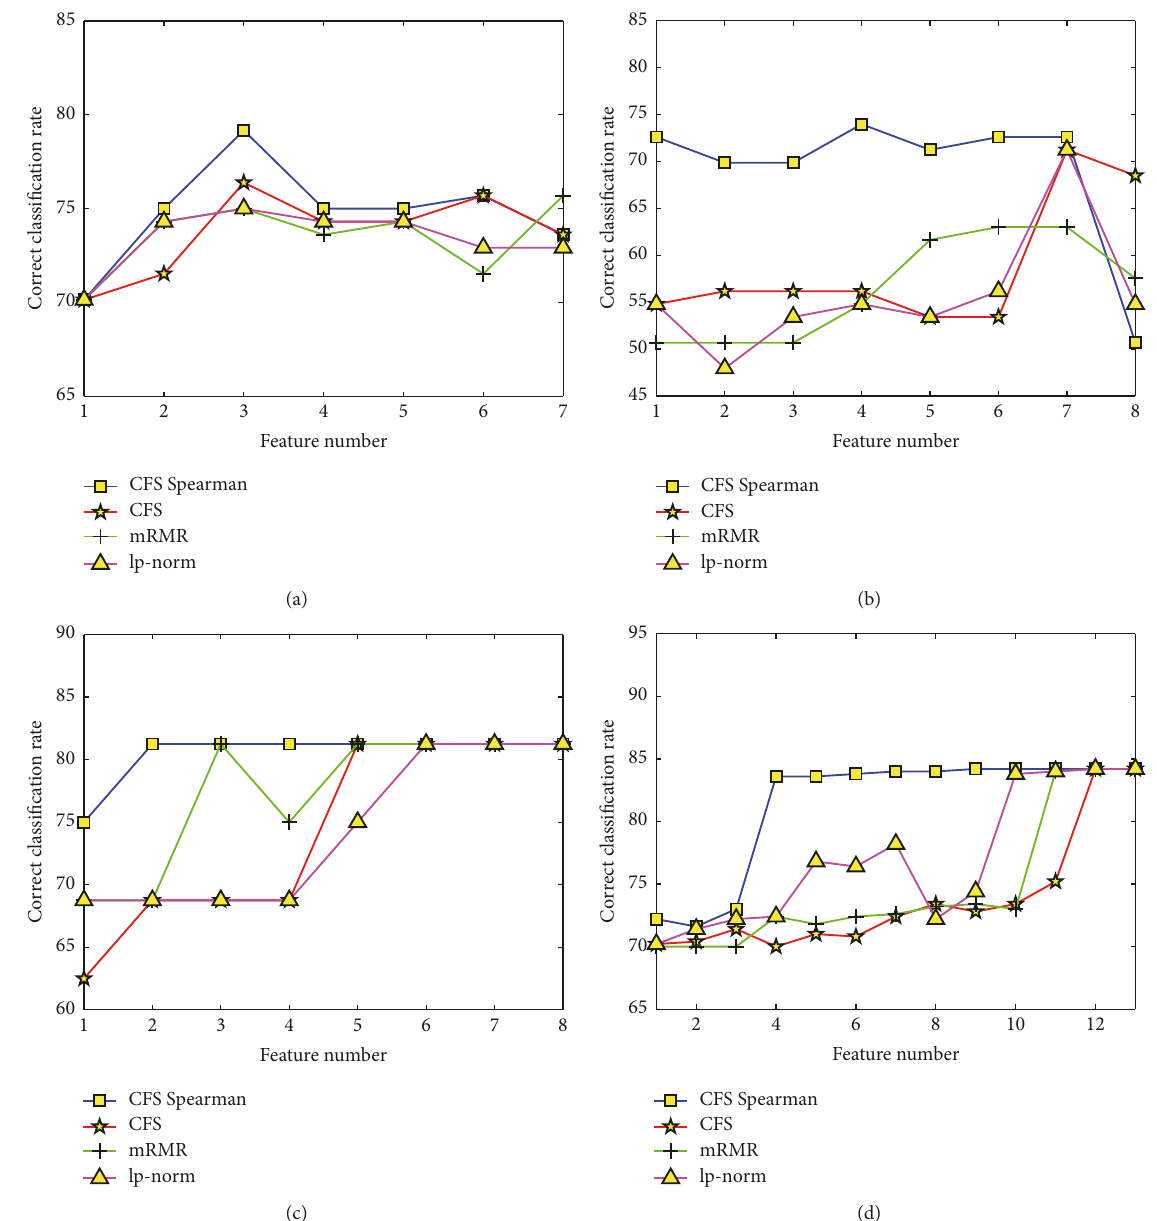
Figure 2: Correct classification rates of different datasets using the 3 methods. (a) Correct classification rates for dataset “Breast-cancer”. (b) Correct classification rates for dataset “Glass”. (c) Correct classification rates for dataset “Bank”. (d) Correct classification rates for dataset